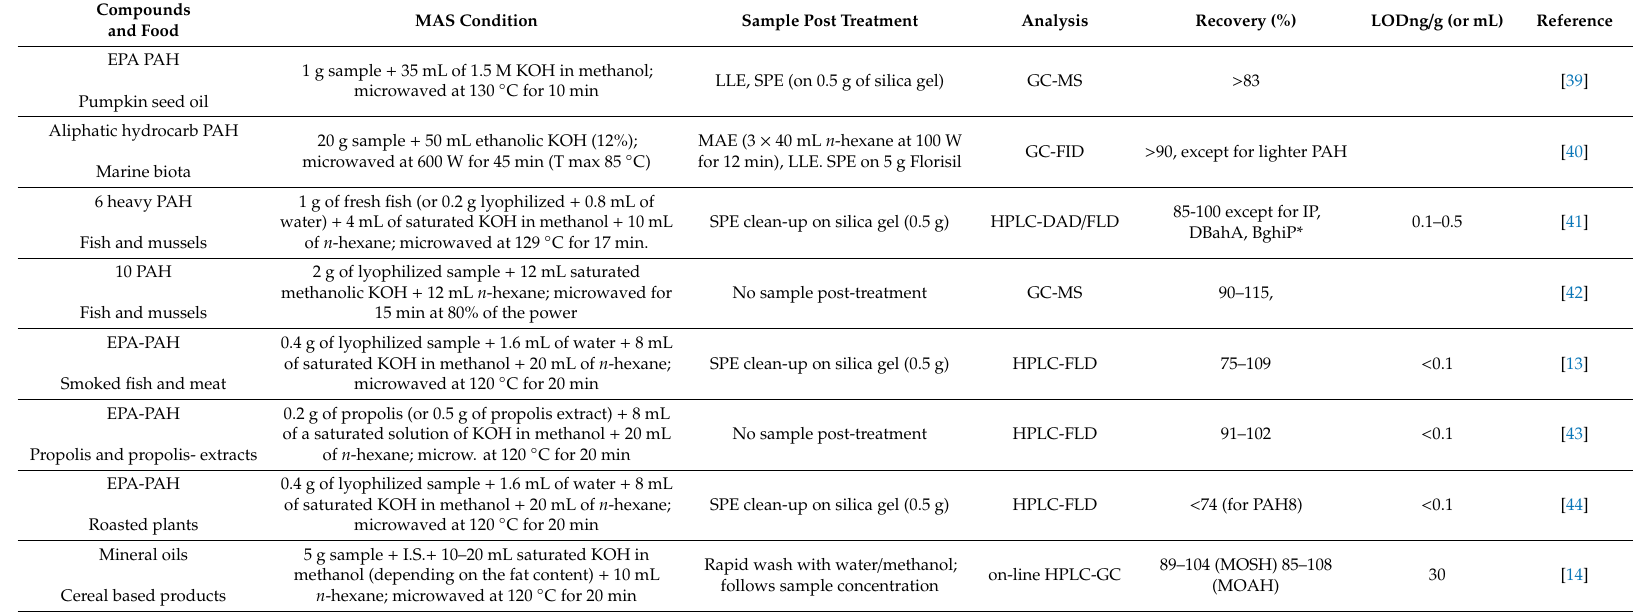
Table 1. Summary of recent microwave-assisted saponification (MAS) applications regarding hydrocarbon contaminants in food. Compounds and